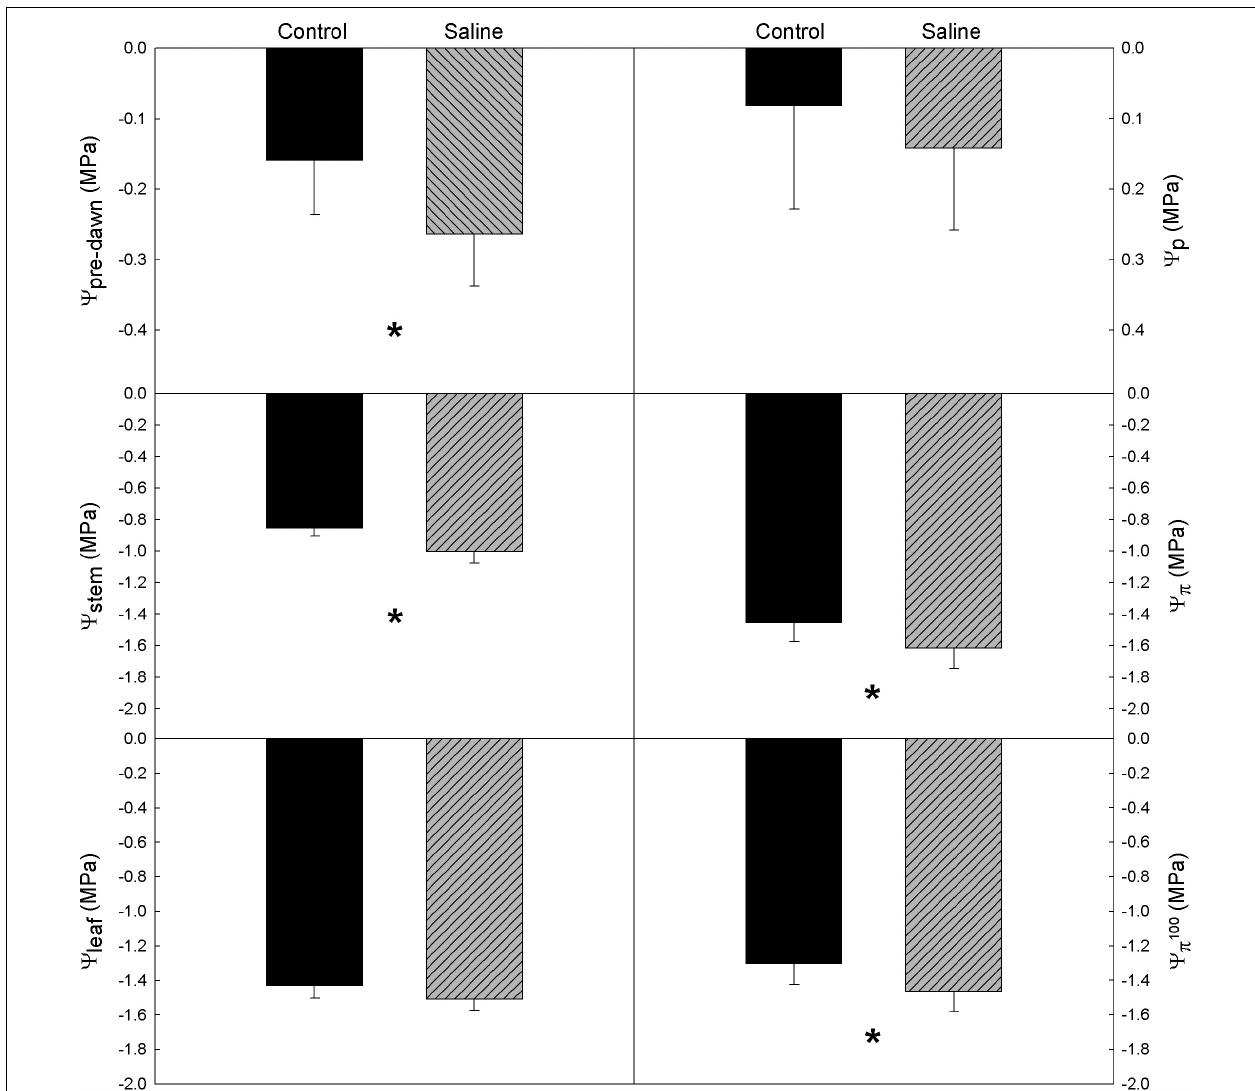
FIGURE 1 | Average values of vine water relations in a Tempranillo vineyard grafted onto M1, M4, and 1103-Paulsen (1P) rootstocks subjected to different water quality (C, control and S, saline irrigation) on DOY 233 of 2019 in Valencia, Spain. (cid:57) pre − dawn , pre-dawn leaf water potential; (cid:57) stem , midday stem water potential; (cid:57) leaf , midday leaf water potential; (cid:57) p , leaf turgor potential; (cid:57) π , leaf osmotic potential; (cid:57) π 100 , leaf osmotic potential at full turgor. Data are averages and standard errors of 9 measurements per water quality. Within each parameter, an asterisk denotes significant differences between treatments at p < 0.05 (Duncan test).